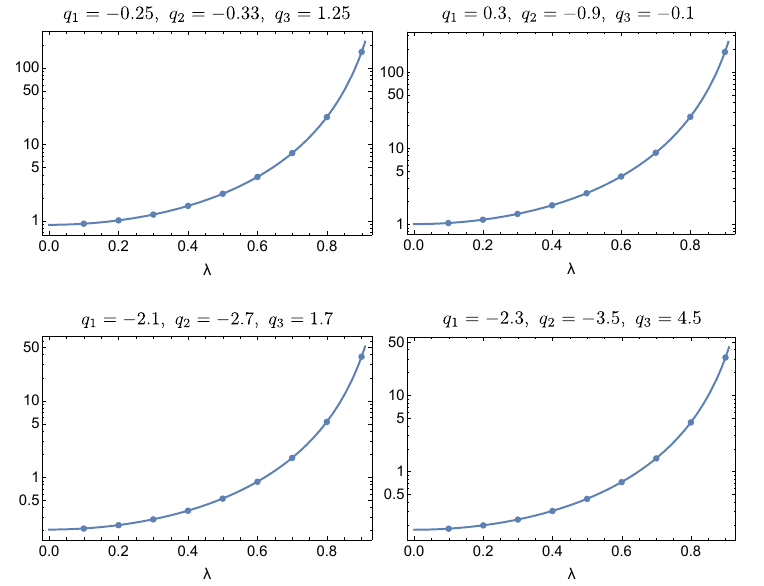
N O qf ( q i ) conn (vertical axis) i π 4 h − i Q